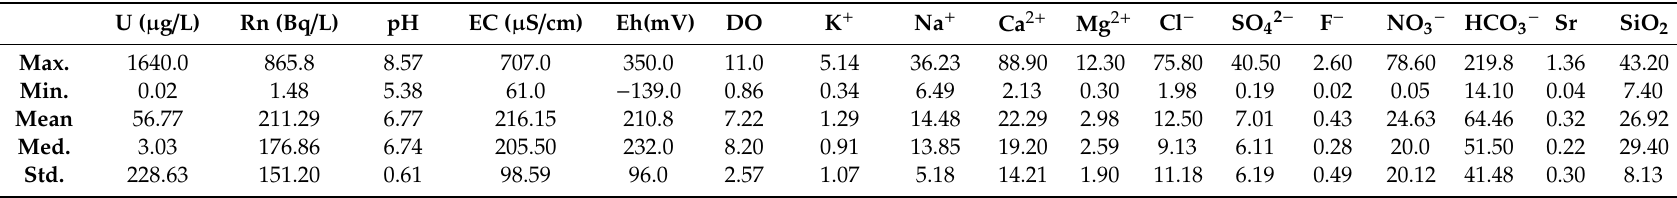
Table 1. Statistical summary on uranium and radon concentrations in groundwater. Concentrations are expressed in mg / L except uranium and radon. Max: